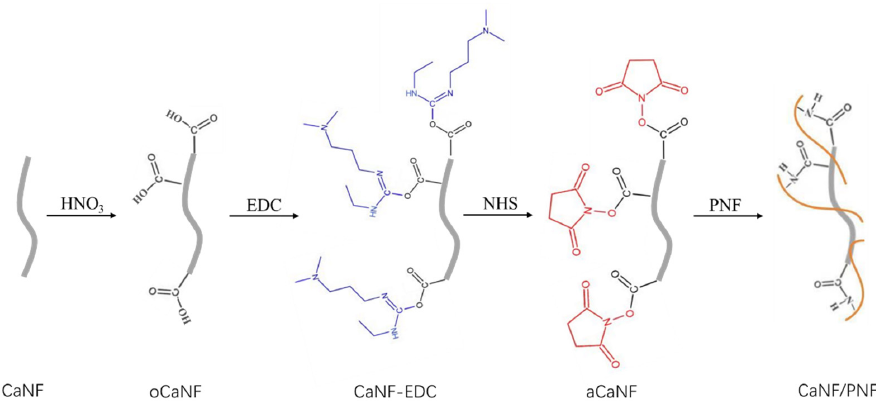
Figure 1. Schematic diagram of the oxidization of CNFs, chemical modification of CaNFs, and chemical binding with PNFs.